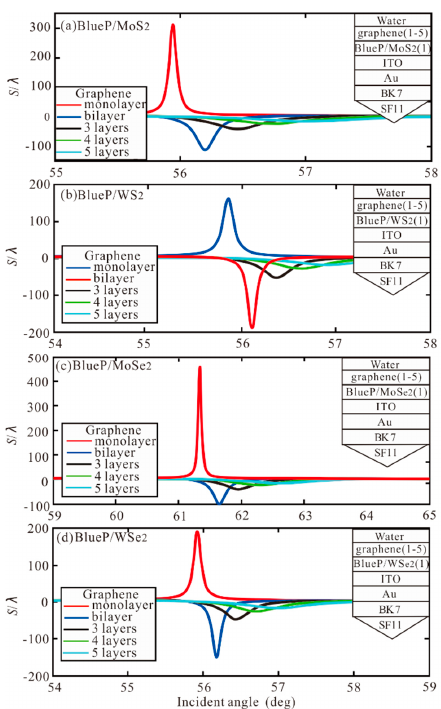
Figure 5. The GH shift with incident angle with graphene monolayer and different number of BlueP/TMDCs ( a ) BlueP/MoS 2 layers, ( b ) BlueP/WS 2 layers, ( c ) BlueP/MoSe 2 layers, ( d ) BlueP/WSe 2 layers.